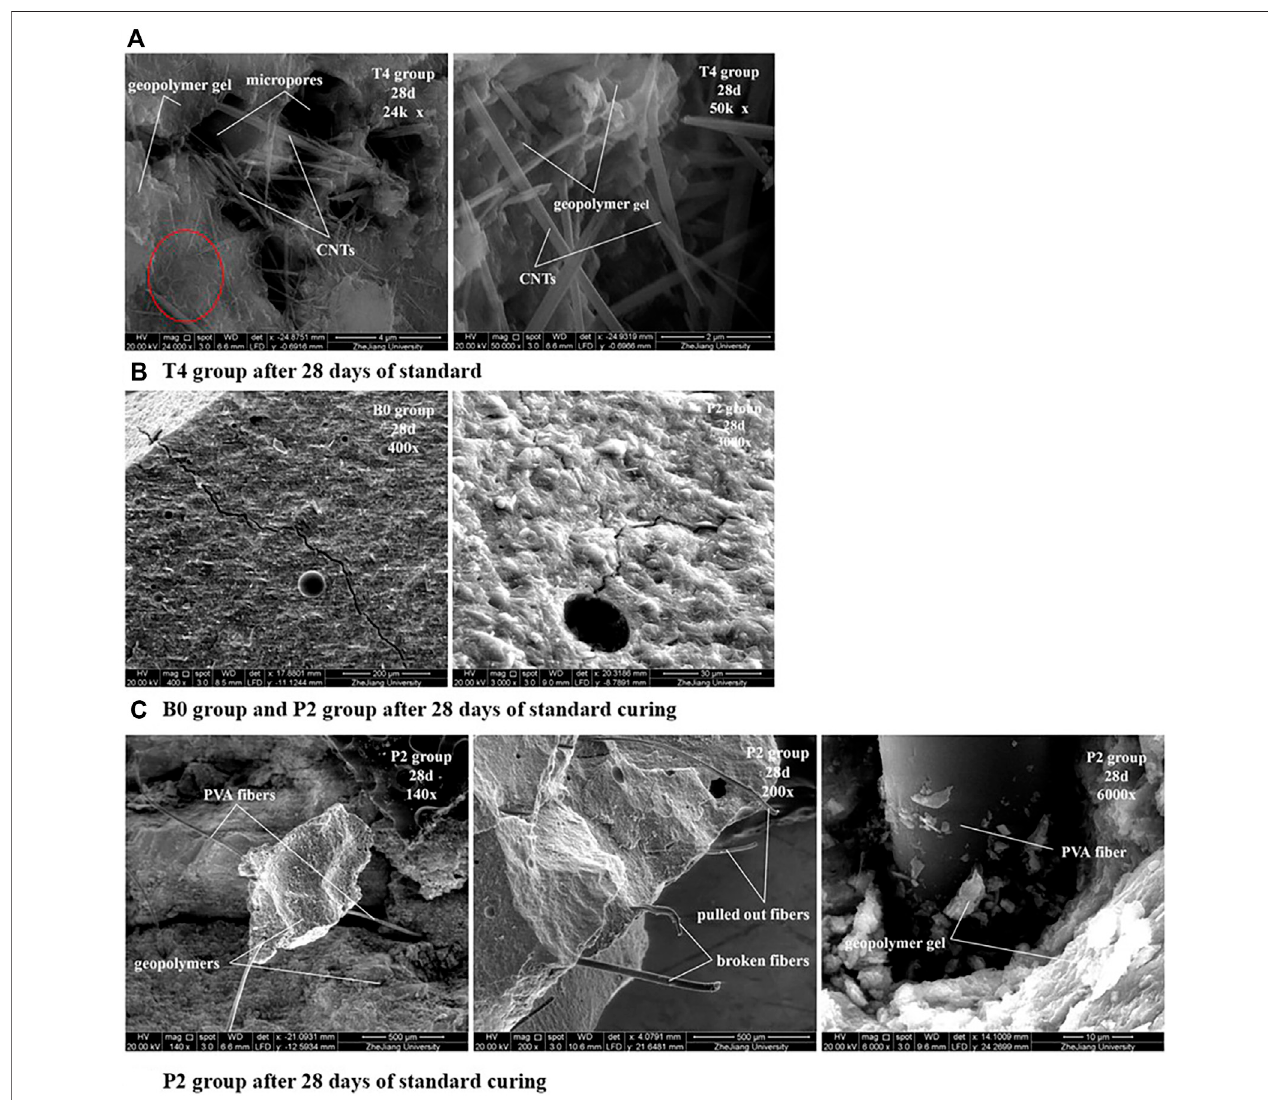
FIGURE 9 | SEM images of